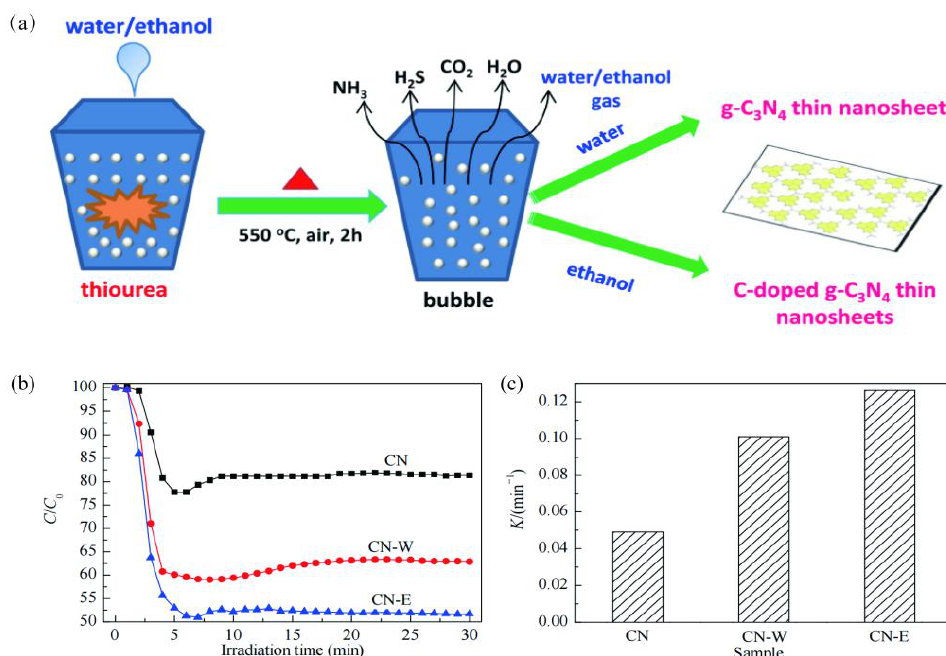
Figure 6. ( a ) Schematic illustration for preparation of porous g − C 3 N 4 with the addition of water and ethanol. Photocatalytic performance ( b ) and Arrhenius rate constants ( c ) of g − C 3 N 4 , g − C 3 N 4 − W and g − C 3 N 4 − E for the removal of NO irradiated under visible light [96]. Copyright 2017, Elsevier.